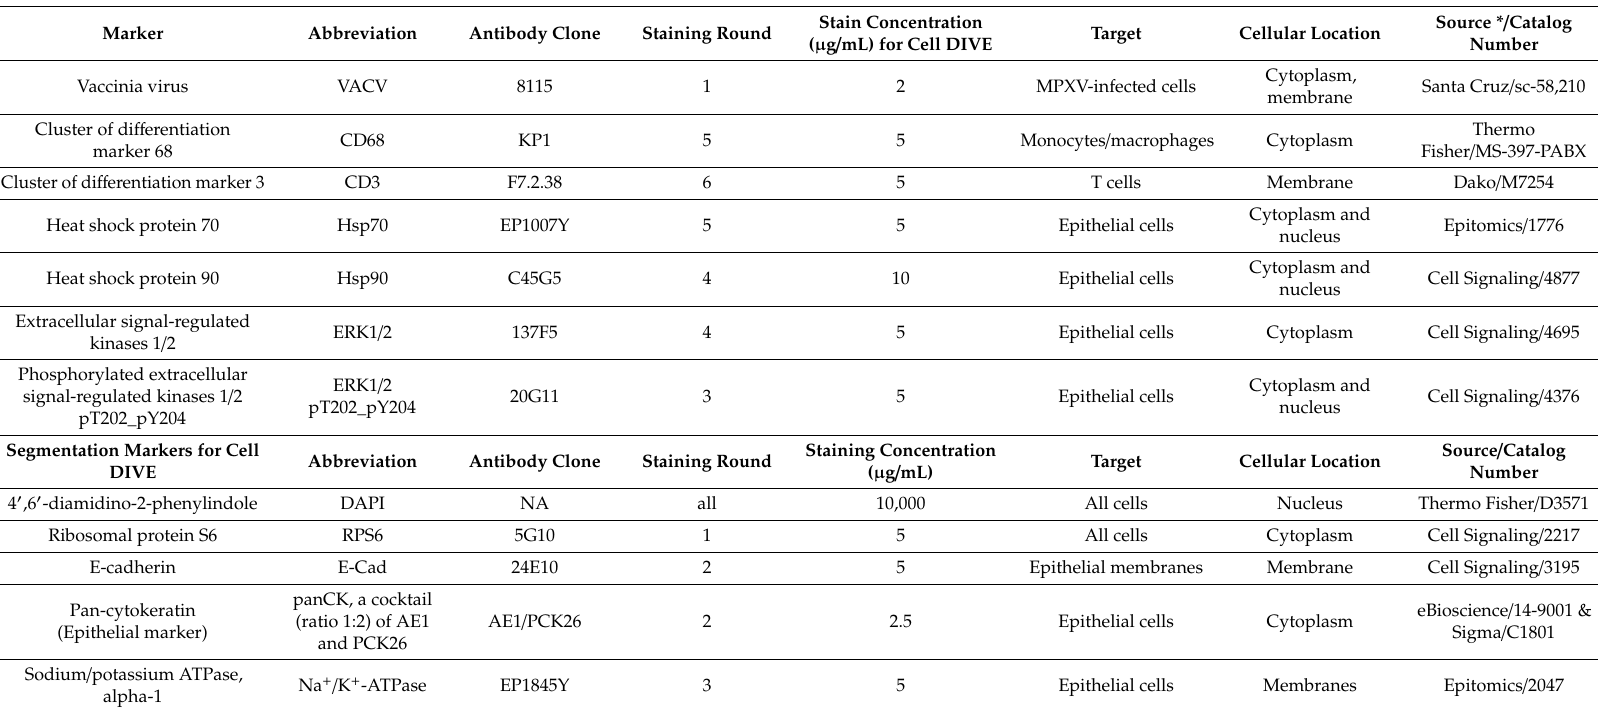
Table 1. Orthopoxvirus-associated protein, biomarkers and image segmentation markers used in this